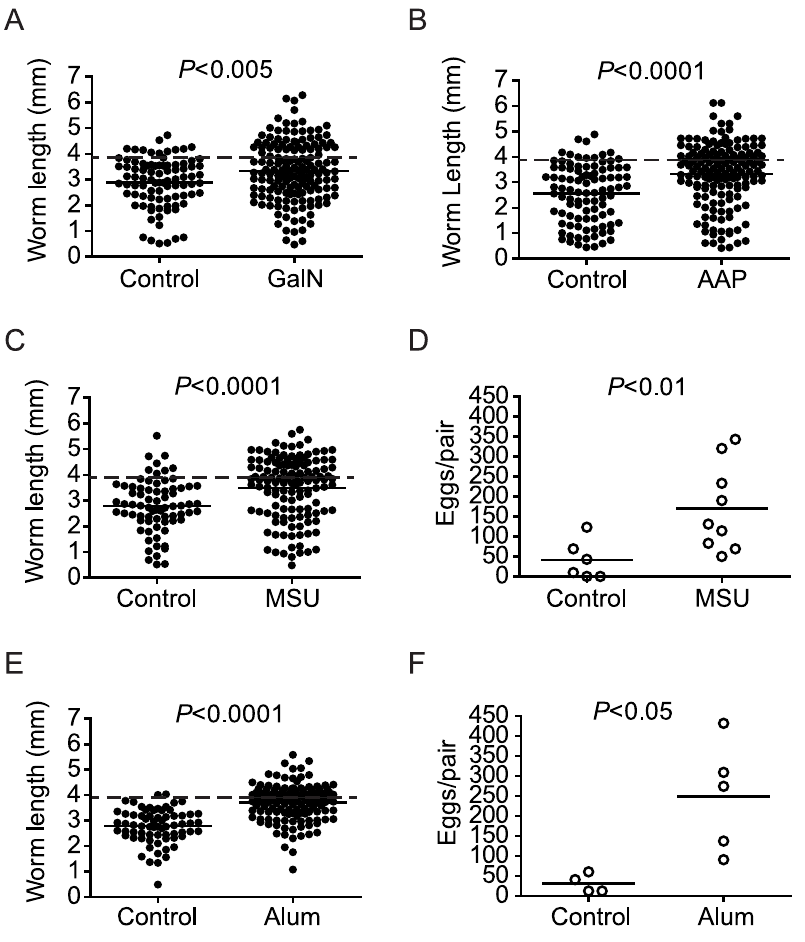
Figure 2. Chronic hepatocyte injury or DAMP administration facilitates S.mansoni development in RAG 2 / 2 mice. Groups of RAG 2 / 2 mice were infected with S. mansoni and treated throughout pre-patent infection with the indicated hepatotoxins or inflammatory stimuli, as described in Materials and Methods. Parasites were perfused from the portal tract and livers removed for egg enumeration at 6 weeks p.i. (A) Length of male worms recovered from RAG 2 / 2 mice chronically treated with D-( + )-galactosamine hydrochloride (GalN). (B) Length of male worms recovered from RAG 2 / 2 mice chronically treated with acetaminophen (AAP). (C and E) Length of male worms and (D and F) liver egg burdens from RAG 2 / 2 mice chronically treated with monosodium urate (MSU; C and D) or alum (E and F). Horizontal bars represent mean values for each experimental group. Groups of 4 to 5 mice were used for each experimental condition. P values for worm lengths determined using student’s T-test with Welch’s correction. P values for egg production determined using the Mann Whitney test. Data shown for the MSU experiment are pooled from two independent experiments. Dashed lines in A, B, C, and E indicate the average length of male S. mansoni worms recovered from wild type mice at day 42 post infection (3.9